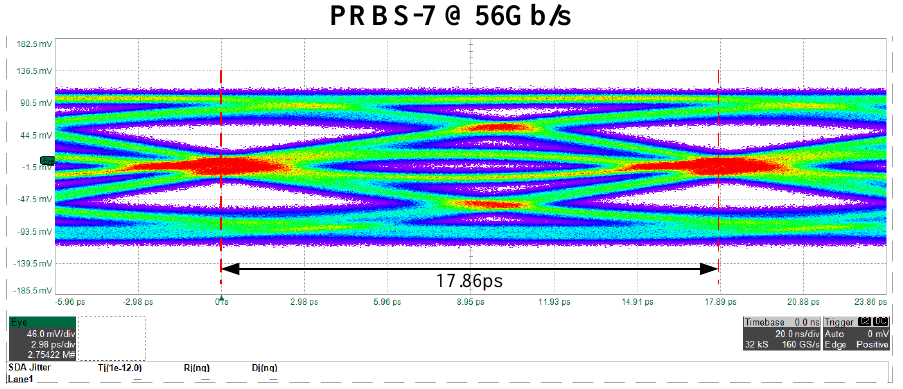
Figure 11. Eye diagram after pre-equalization.